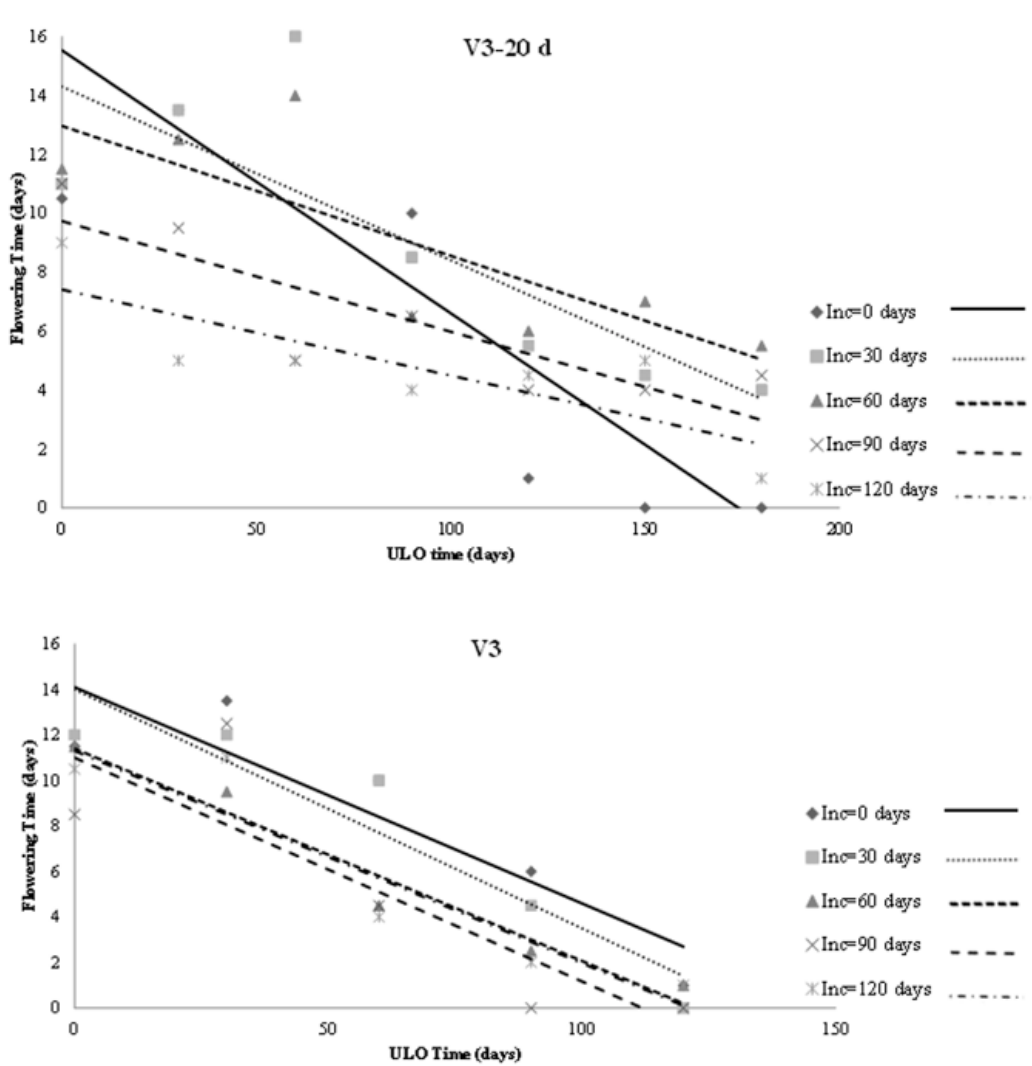
Figure 4. Graph of the flowering time (days) for different incubation times during the ULO storage, for the different vegetative stages studied (V3–20 d and V3).